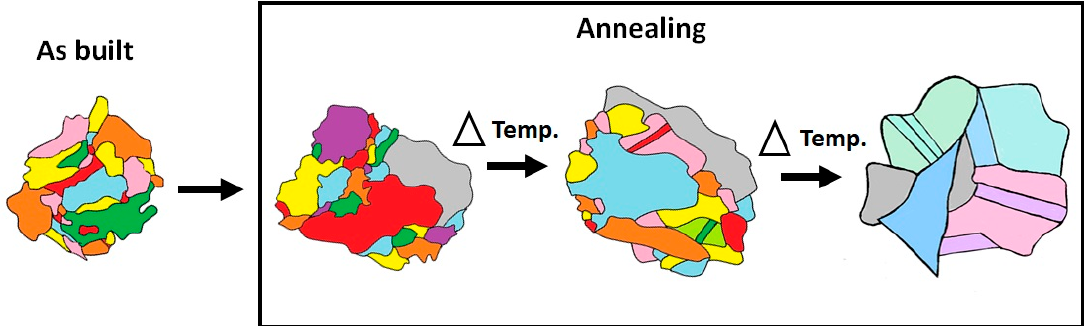
Figure 5. Microstructural evolution of the Cantor alloy from the “as built” state after annealing.